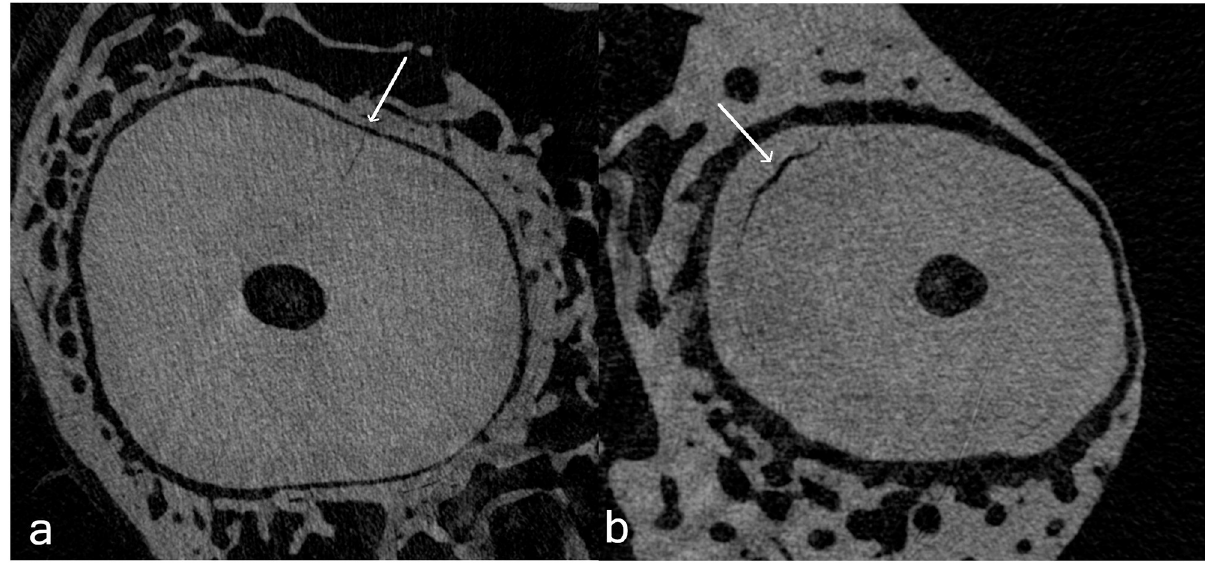
Fig 3. Preoperative microcrack and defect. Representative cross-sectional slices with a preoperative microcrack (a) and defect (b).